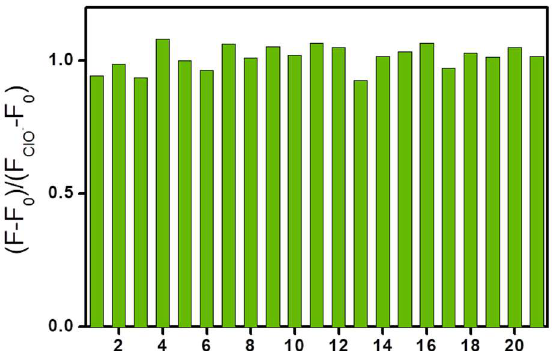
Figure 2. Emission spectra response of RHN (10 μM; 10 mM, pH = 7.4, PBS) upon addition of different species (100 μM) in the presence of ClO − (50 μM). (1) 1 O 2 ; (2) Cys; (3) GSH; (4) H 2 O 2 ; (5) blank; (6) Hcy; (7) HSO 3− ; (8) HSO 4− ; (9) TBHP; (10) NO; (11) NO 2− ; (12) NO 3− ; (13) O 2− ; (14) •OH; (15) ONOO − ; (16) S 2− ; (17) S 2 O 32− ; (18) S 2 O 42− ; (19) S 2 O 82− ; (20) SO 32− ; (21) SO 42− . The conditions: PBS buffer (10 mM, pH = 7.4); λ ex = 500 nm; slits: 10/5 nm.